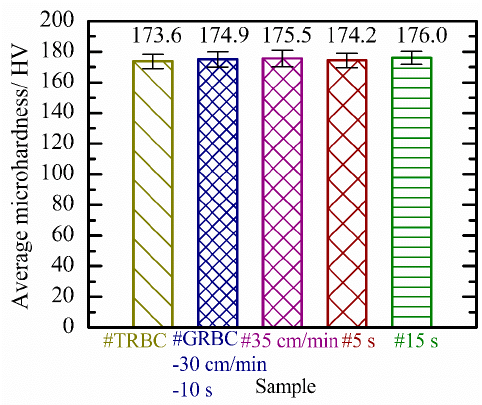
Figure 10. Average microhardness values of different samples. (TRBC and GRBC represent transient and gradual reduction of bottom current, respectively).